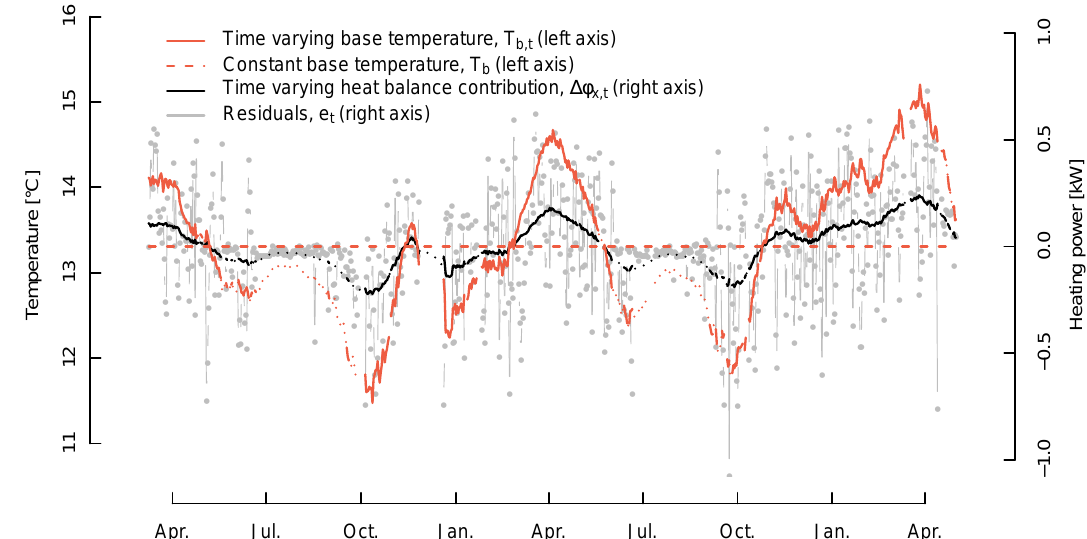
Figure 4. Plot of residuals ( e t ), time-varying heat balance contribution ( ∆ Φ x, t ), constant base temperature ( T b ) and time-varying base temperature ( T b, t ). The figure shows how the time-varying heat balance contribution, ∆ Φ x, t , is estimated from the model residuals from model M3 applied on data from House 6. From the estimate of ∆ Φ x, t , the time-varying base temperature is estimated.